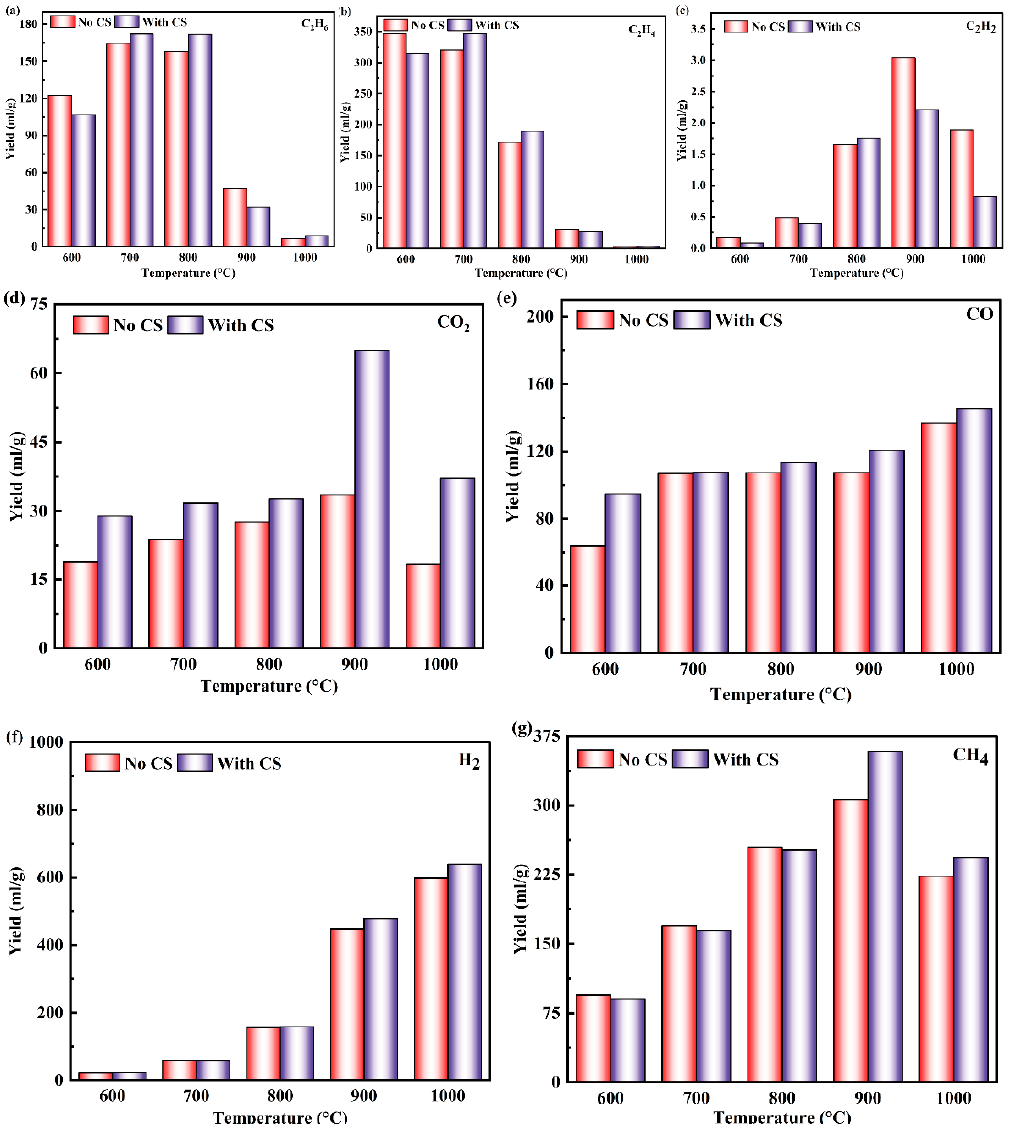
Figure 10. Effect of CS on gas products at different pyrolysis temperatures: ( a ) C 2 H 6 ; ( b ) C 2 H 4 ; ( c ) C 2 H 2 ; ( d ) CO 2 ; (e) CO; ( f ) H 2 ; ( g ) CH 4 .